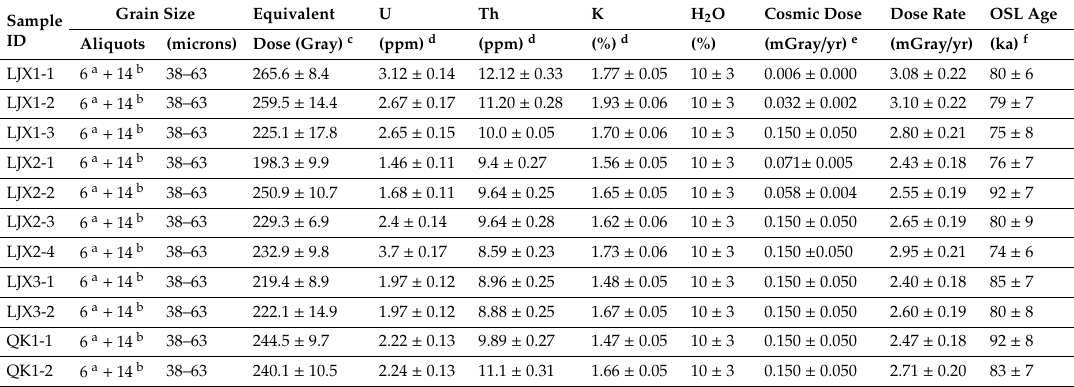
Table A1. OSL ages on quartz extracts and associated data of lacustrine sediments from our previous work